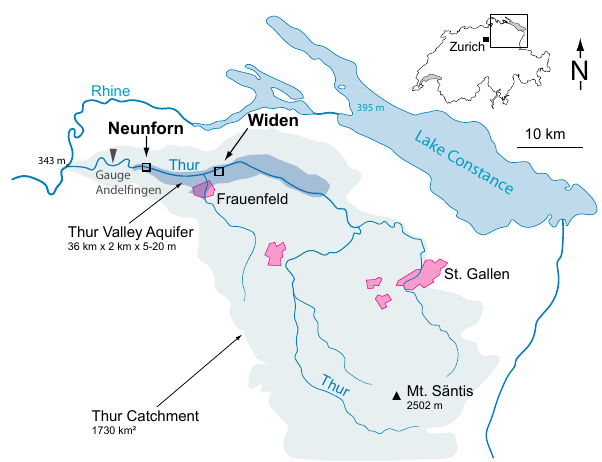
Fig. 1. Location of the Thur catchment, the Thur valley aquifer and the test sites at Neunforn (partly restored) and Widen (channelized) in NE